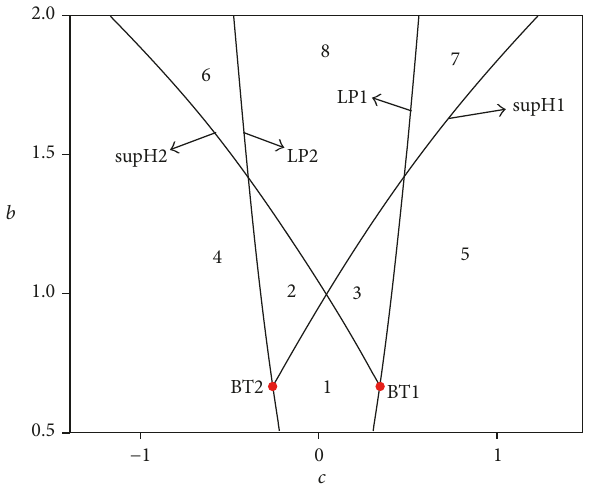
Figure 1: Two bifurcation sets of the system with respect to parameters 𝑏 and 𝑐 , for fixed 𝑎 = 1 . BT1 and BT2 represent the two Bogdanov-Takens bifurcation points; LP1 and LP2 represent the twofold bifurcation curves; and supH1 and supH2 represent the two Hopf bifurcation